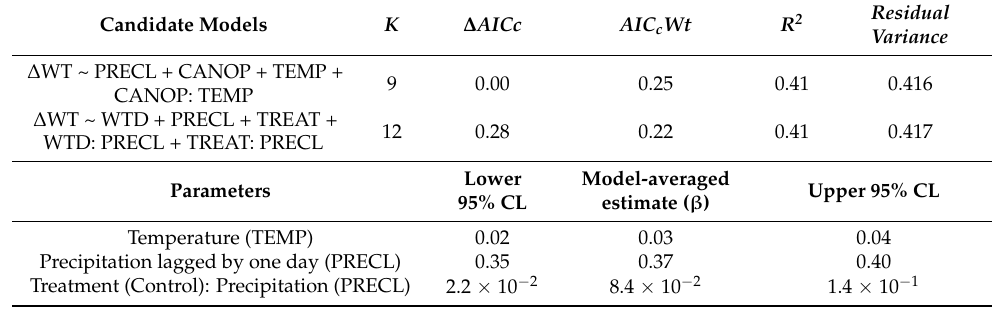
Table 6. Most parsimonious models of silvicultural treatment and stand characteristic explaining daily variation in water table depth ( ∆ WT ) after treatment, including the number of parameters ( K ), difference in AIC c compared to highest-rankedmodel ( ∆ AIC c ), AIC c model weight ( AIC c Wt ), and predictive power (marginal R 2 ). Parameters appearing in the second portion show the variables for which 95% confidence intervals exclude 0 and that influenced the response variable. The count of parameters includes the variance associated with the block random effect, the treatment within block random effect and the residual variance. Note that girdling was the reference level of the treatment variable.